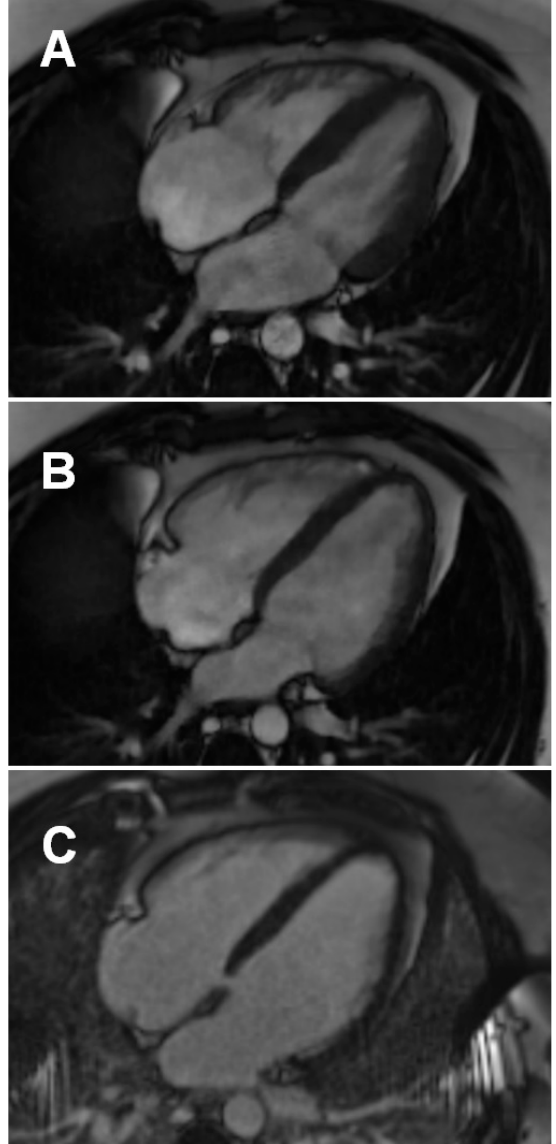
Figure 3. An example of right ventricular enlargement and mild systolic dysfunction in a 26-year-old hospitalized male patient 22 days post COVID-19 pneumonia: Four-chamber systolic ( A ) and four- chamber diastolic ( B ) still frames from routine balanced steady state free precession cine sequence (RVEDV 258 mL; mildly reduced RVEF of 39%). ( C ) No late gadolinium enhancement is visible in the myocardium in a four-chamber PSIR sequence acquired 10 min post contrast injection (Gadovist 0.1 mmol/kg, Bayer, Leverkusen, Germany). Images acquired on Magnetom Sola 1.5T, Siemens, Erlangen, Germany. PSIR, phase-sensitive inversion recovery; RVEDVI, right ventricular end-diastolic volume index; RVEF, right ventricular ejection